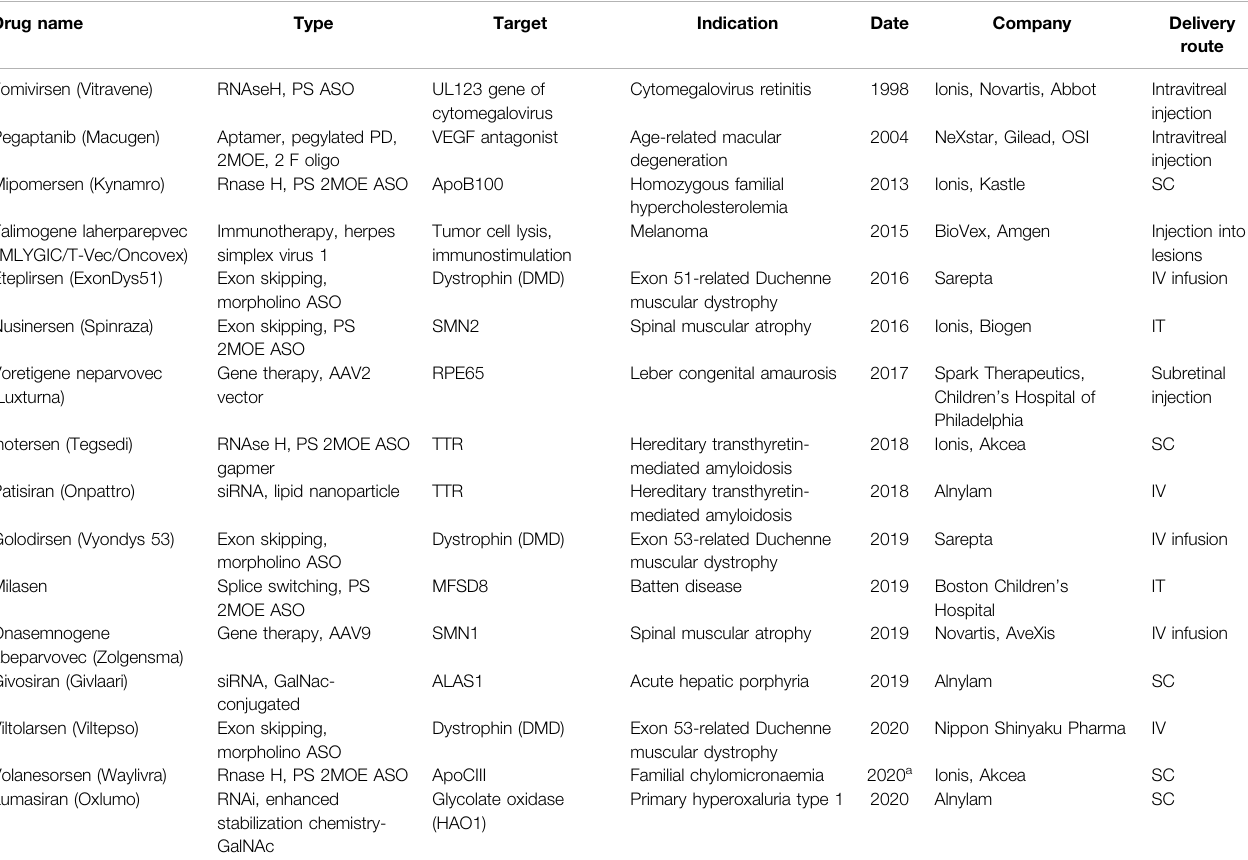
TABLE 1 | Nucleic acid – based therapeutics approved by the FDA as of November